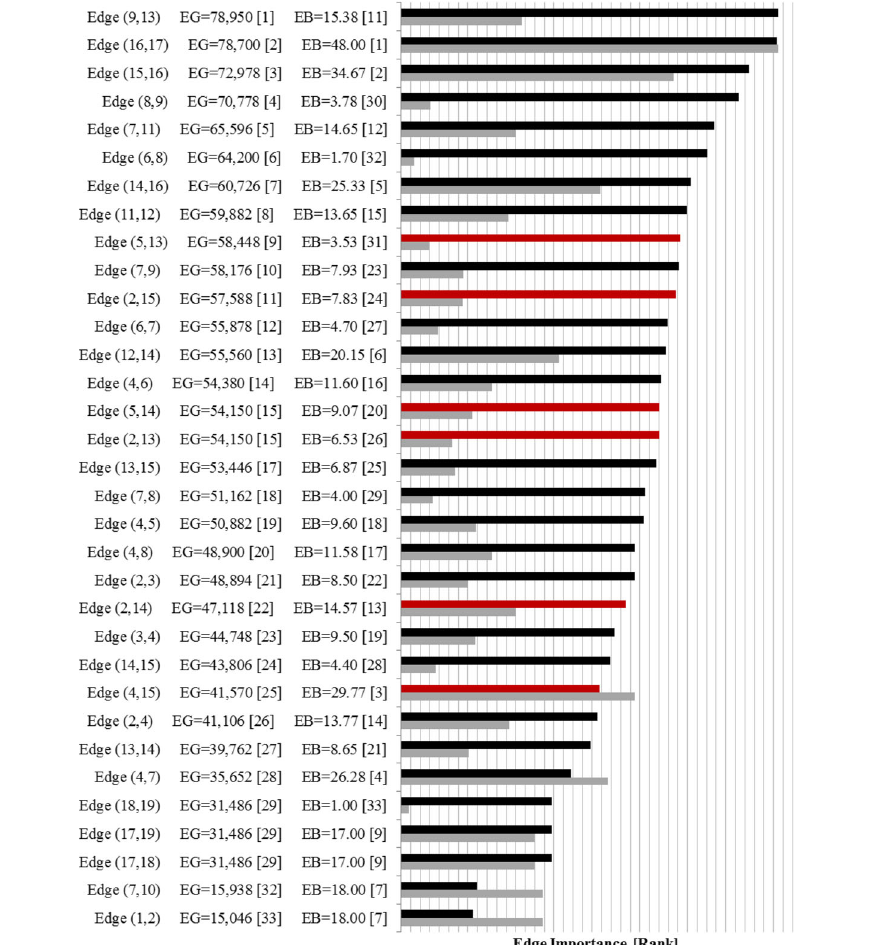
only 16th according to Edge Gravity, while edge (2,9) ranks 12th. Note also that the top three edges for Edge Gravity rank only fourth, seventh, and 14th for edge